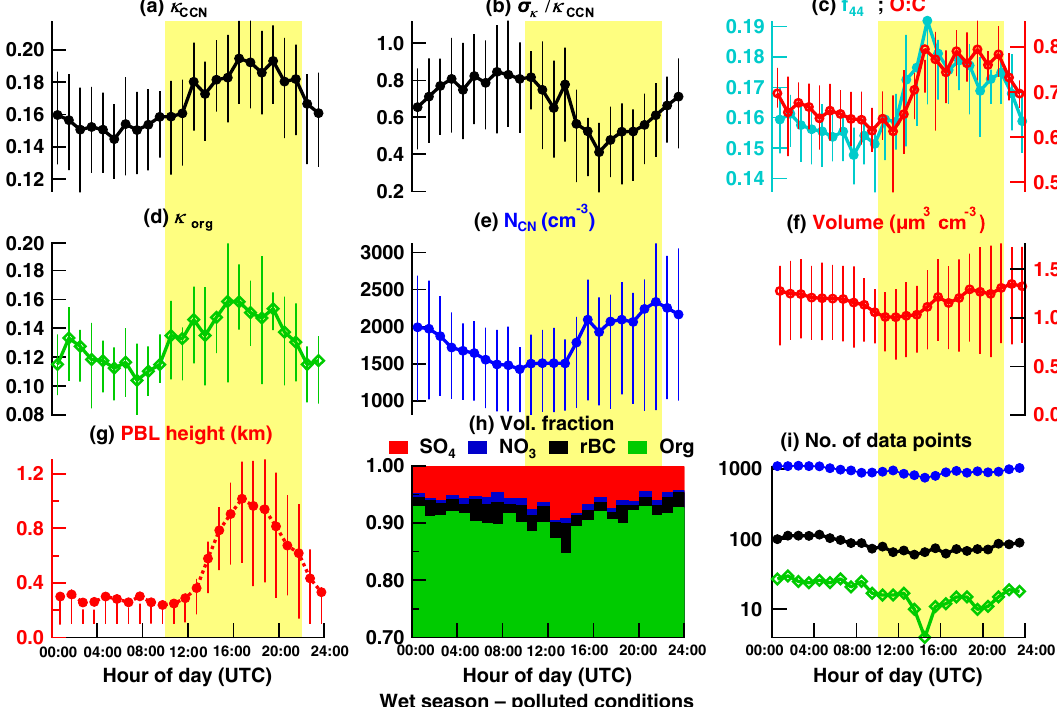
Figure 4. Diel variations of aerosol properties and meteorological parameters for urban pollution air masses during the wet season (analogous to Fig.